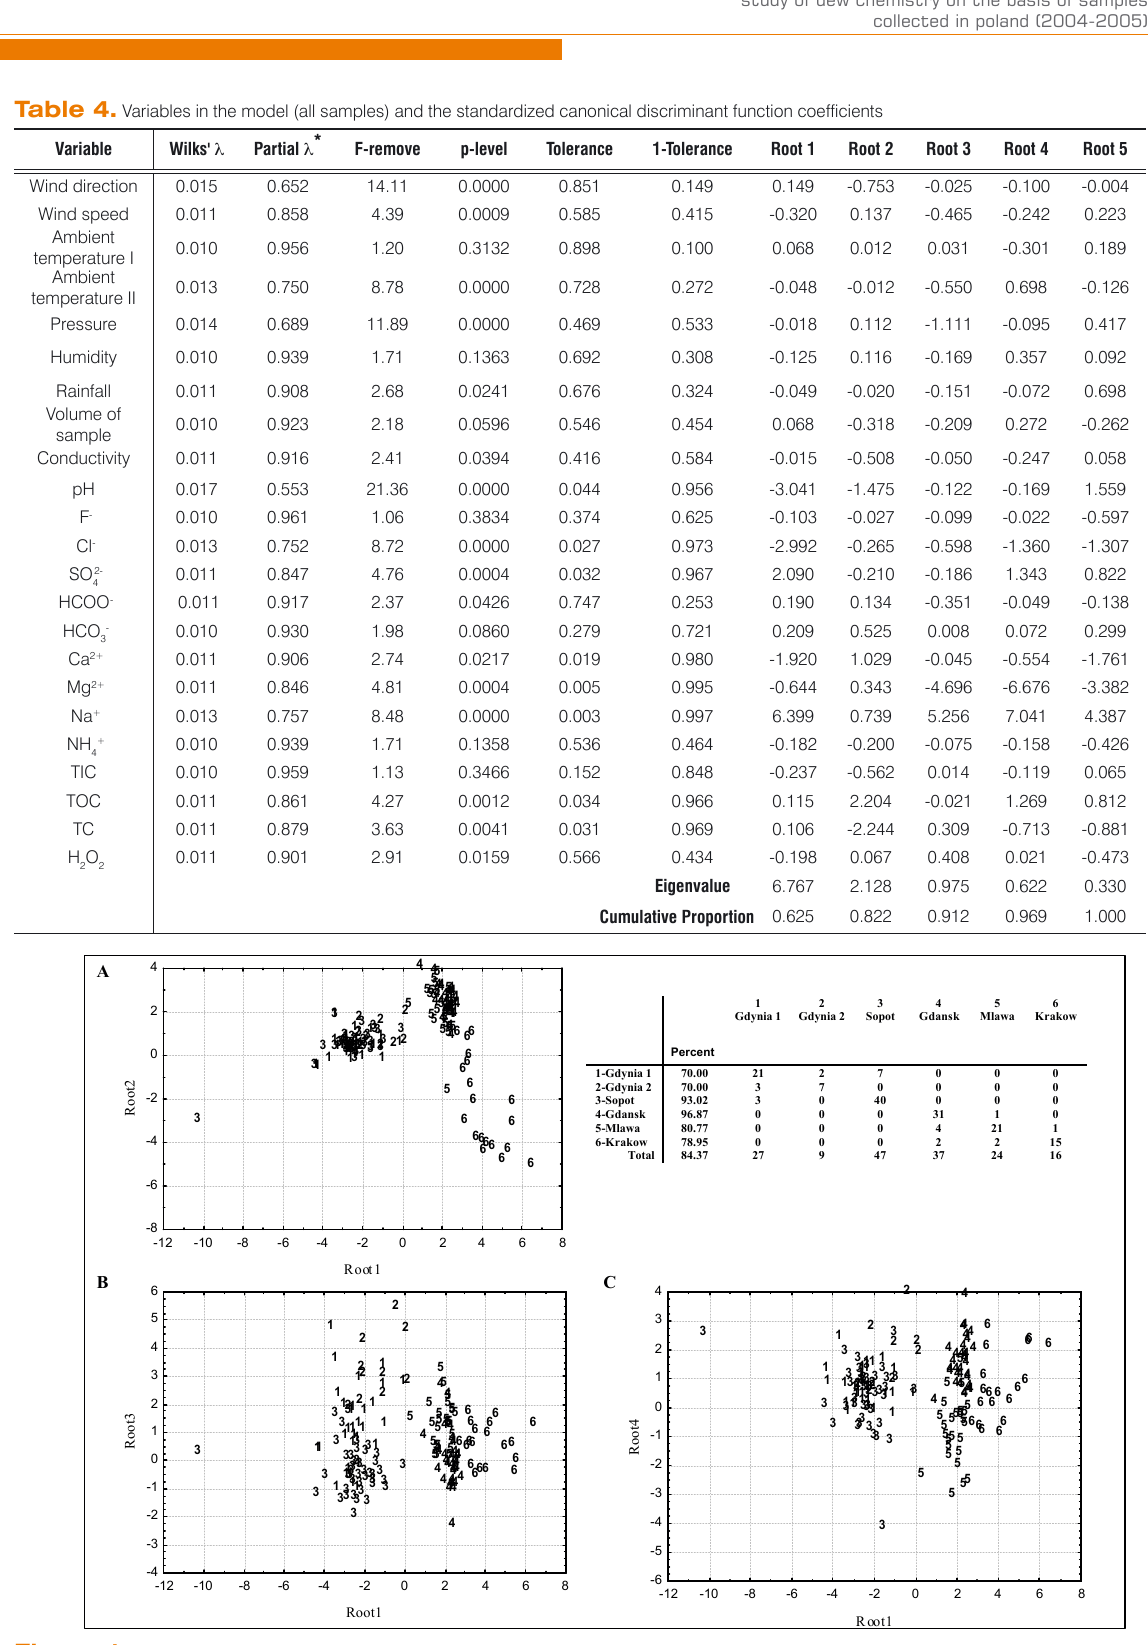
Figure 1. Scatterplot of canonical scores on the plan described by: A - root 1 and root 2; B - root 1 and root 3; C - root 1 and root 4 (all